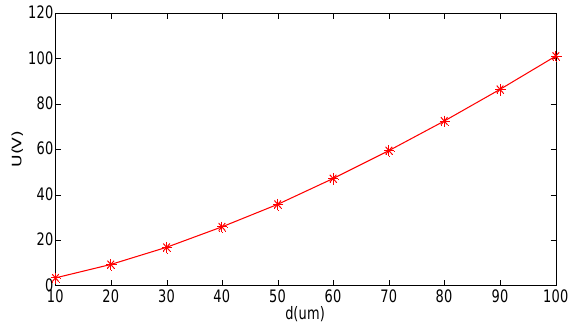
Figure 10. The curve of installation distance d with the tuning voltage